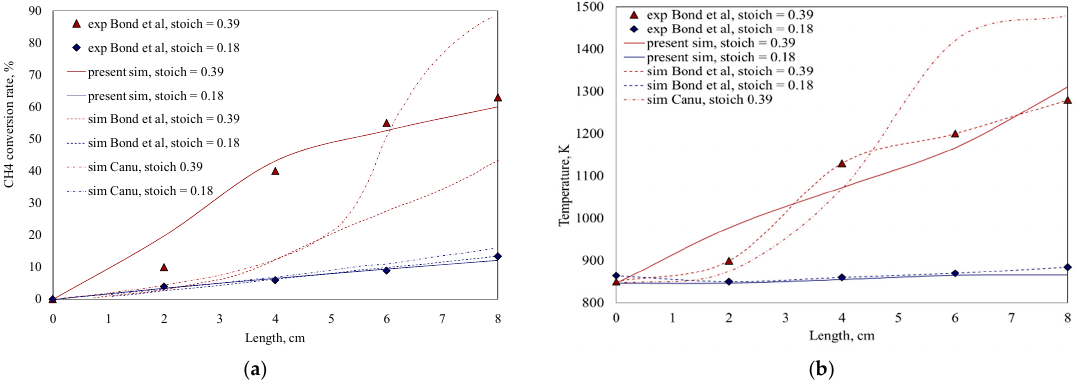
Figure 4. Experimental data by Bond et al. [40] and comparison with numerical data by Bond et al. [40] and Canu [41] at low and high inlet stoichiometry for ( a ) methane conversion and ( b ) temperature distributions.